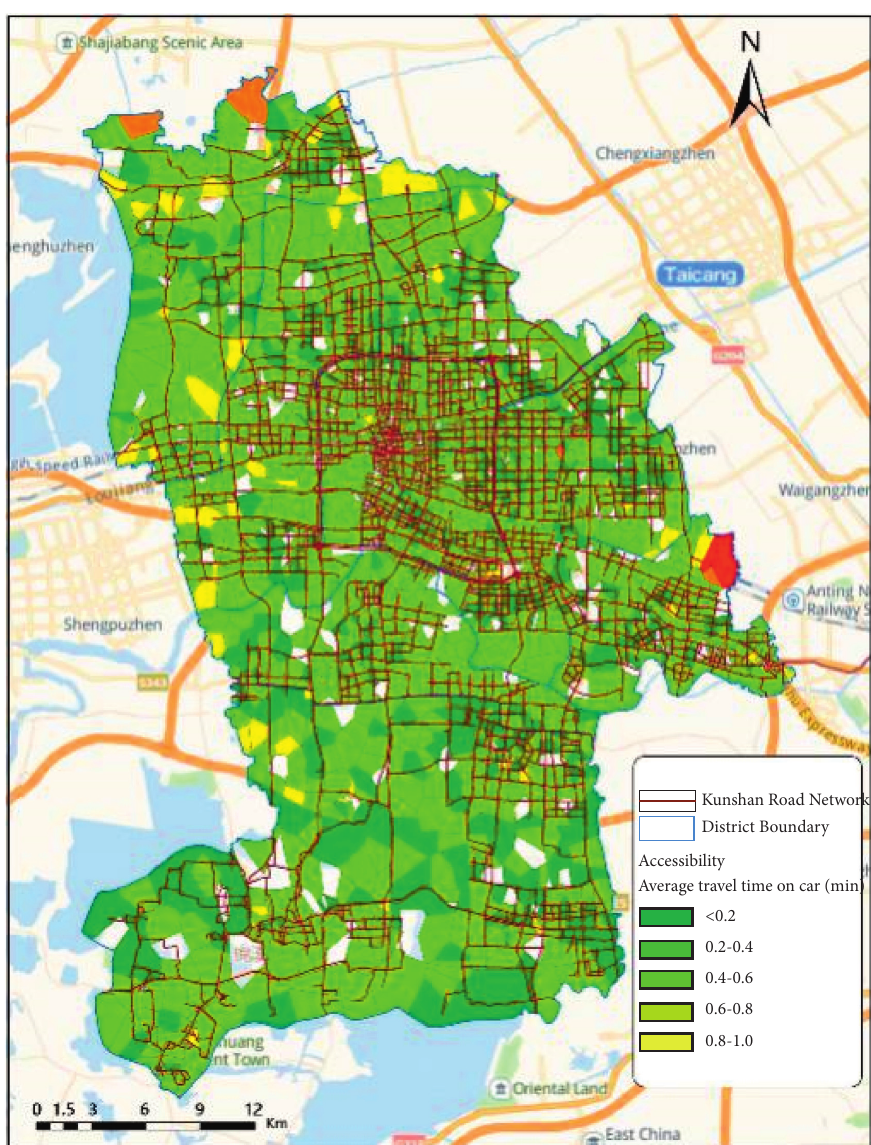
Figure 3: Minibus accessibility. The blank base station cell in the figure is the result of processing the mobile phone data after noise reduction and represents a base station cell with no valid travel